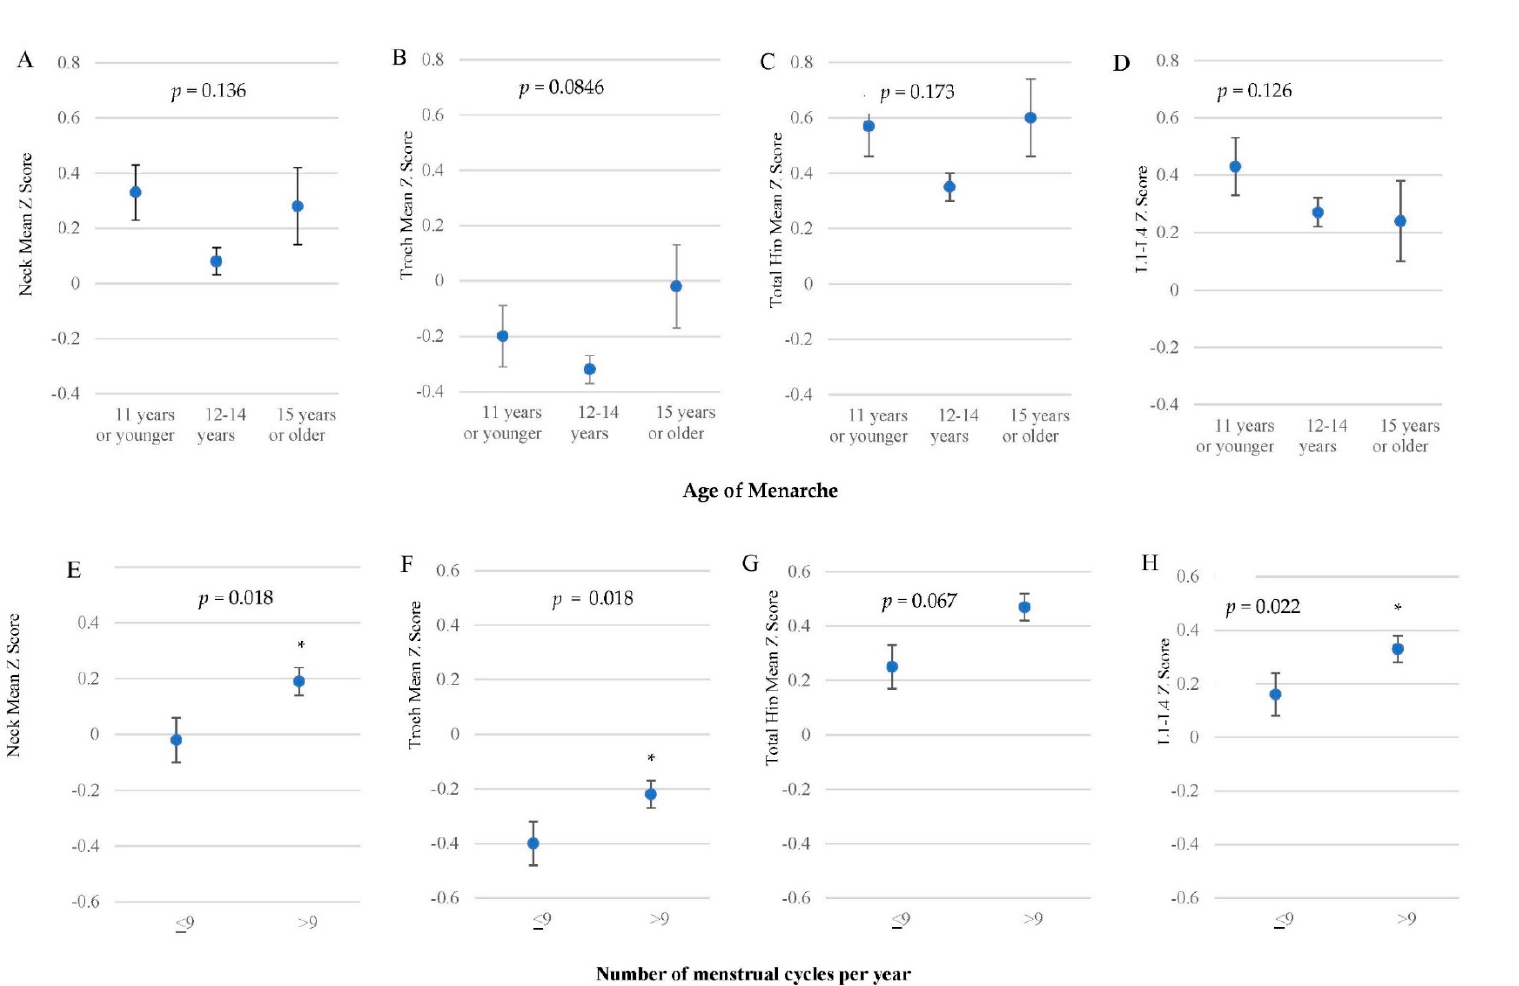
Figure 1. Comparison of age at menarche and number of menstrual cycles per year during 18-month study period of interest with mean ± standard error BMD Z-score at each measurement site. ( A – D ), Age of menarche: 11 years or younger ( n = 84); 12–14 years ( n = 368); 15 years or older ( n = 48). No significant difference between groups; p < 0.0125. ( E – H ), Number of menstrual cycles per year: ≤ 9 ( n = 230); >9 ( n = 276), * indicates a significant difference, p < 0.05. Survey respondents were not required to answer every question, so n might not total 641.